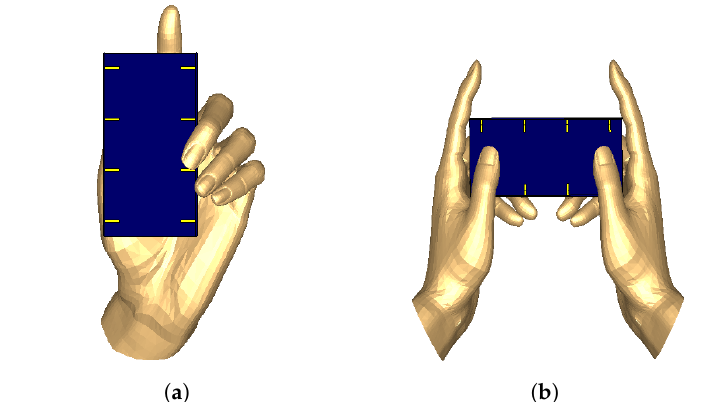
Figure 10. User hand influence of ( a ): single hand mode (SHM) and ( b ): two hand mode (THM).